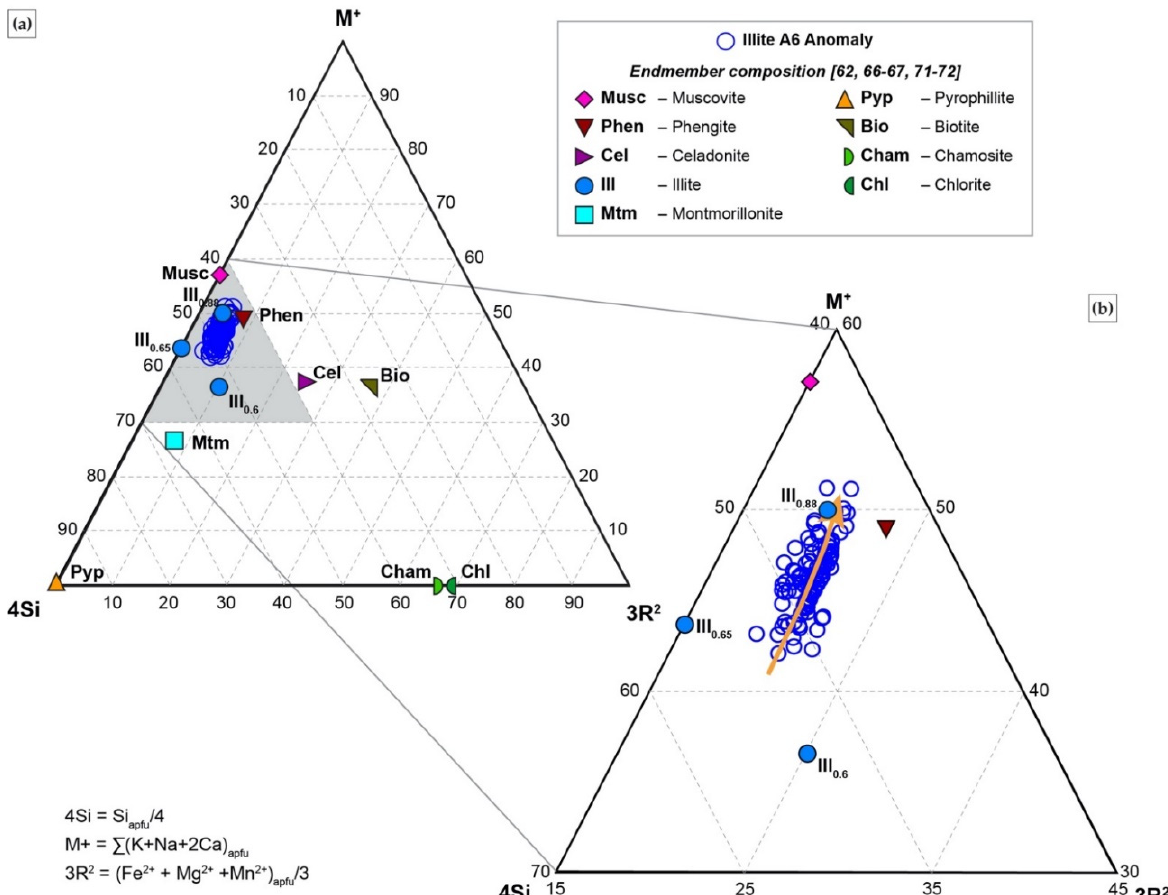
Figure 17. Box-Percentile plots showing range in major and minor elements in apfu within analyzed illite. ( a ) Si and total Al; ( b ) Elements Fe 2+ and Mg 2+ on the octahedral site and their sum; ( c ) Elements Ca, Na, and K on the interlayer site and their sum.